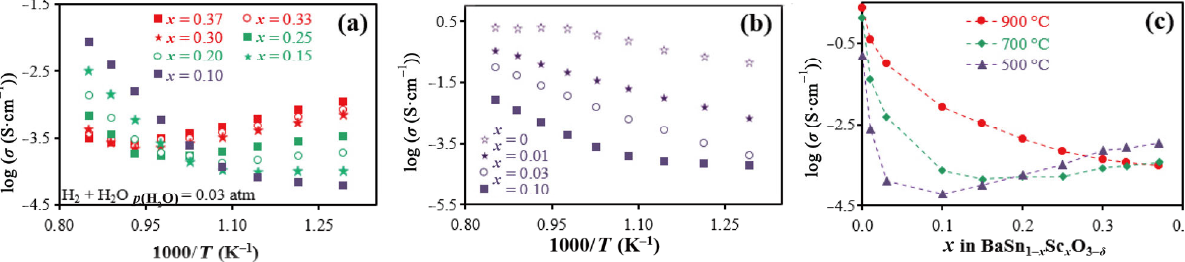
Fig. 5 Temperature dependence of the BaSn 1 − x Sc x O 3 − δ total σ in wet hydrogen atmosphere ( p (H 2 O) = 0.03 atm) at 500–900 ℃ for (a) 0 ≤ x ≤ 0.10 and (b) 0.10 ≤ x ≤ 0.37, as well as (c) its concentration